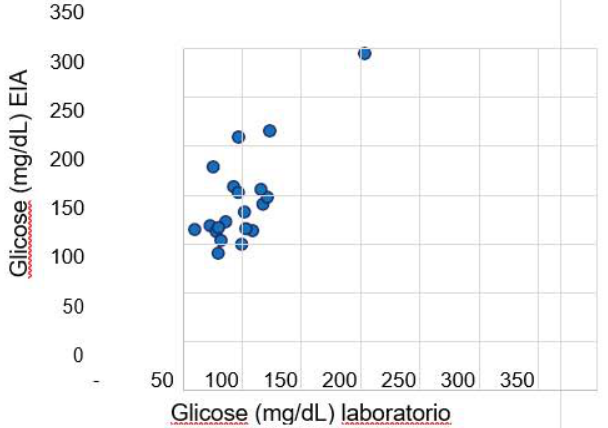
fIGuRE 4 – Mean glucose concentration determined by glucometer (HGT), artificial intelligence equipment (EIA) and conventional laboratory dosage. Results expressed as mean ± standard